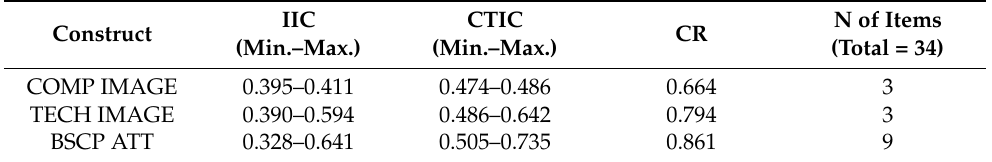
Table 6. Constructs IIC, CTIC, and